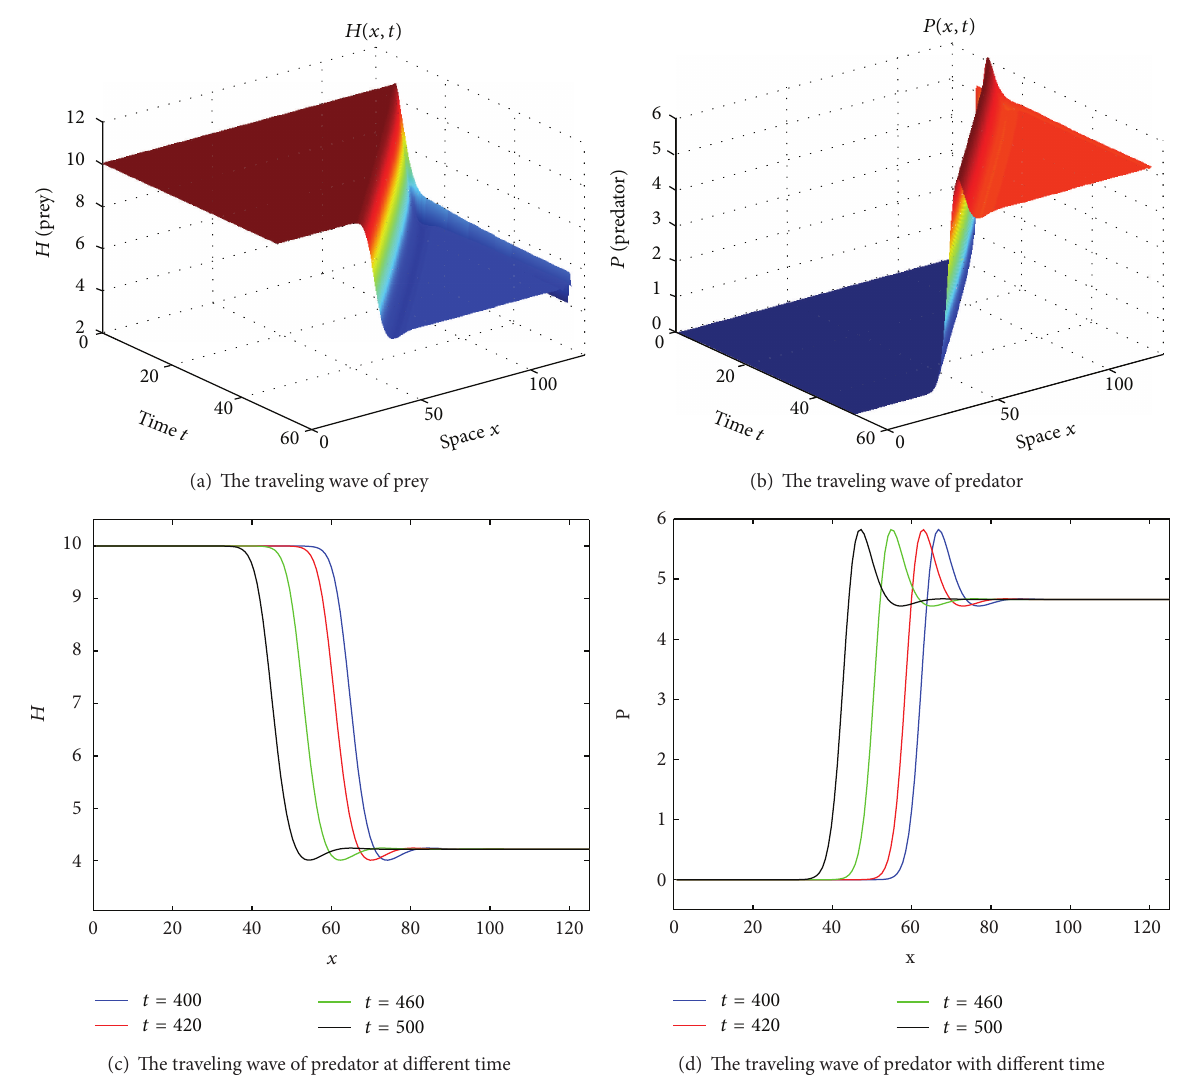
Figure 2: The traveling wave solution of system (8) from 𝐸 1 (10, 0) tends to 𝐸(𝐻 ∗ , 𝑃 ∗ ) nonmonotonously with the parameters 𝐷 = 0.8 , 𝑟 = 1.5 , 𝑎 = 0.15 , 𝑚 = 0.35 , 𝑏 = 0.15 , 𝑑 = 1 , and 𝛽 = 0.75 .